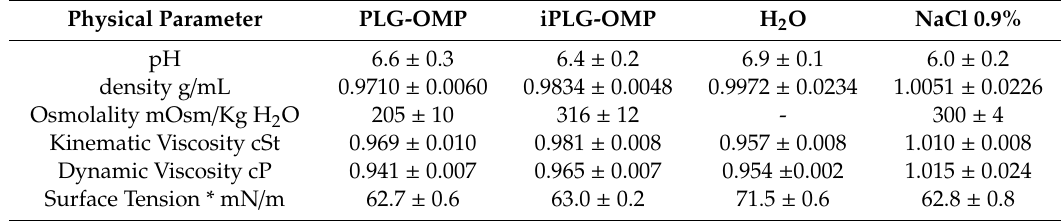
Table 1. Physical properties of human plasminogen (PLG-OMP) and iPLG-OMP solutions evaluated at (22 ± 2 ◦